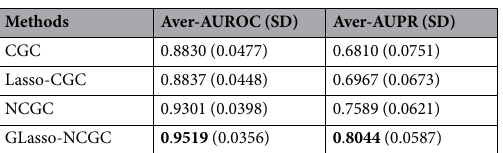
where state vector x = [ x 1 , x 2 , … , x N ] T , the first term on the right-hand side of Equation (8) describes the self-dynamics of the i -th variable, while the second term describes the interactions between variable i and its interacting partners j . The nonlinear functions F ( x i ) and H ( x i , x j ) represent the dynamical laws that govern the variables of system. Let B be the adjacent matrix which describes the interactions among variables. b ij ≠ 0 if the j -th variable connects to the i -th one; otherwise, b ij = 0. ε i is zero-mean uncorrelated gaussian noise with vari- ance σ 2 . Indeed, these is no unified manner to establish the nonlinear framework for all the complex networked systems. But Equation (8) has the broad applications in many science domains. With an appropriate choice of F ( x i ) and H ( x i , x j ), Equation (8) is used to model various known systems, ranging from ecological systems, social systems and physical systems 11, 18, 40, 42 . Specifically, Equation (8) can be transformed into discrete-time expressions.